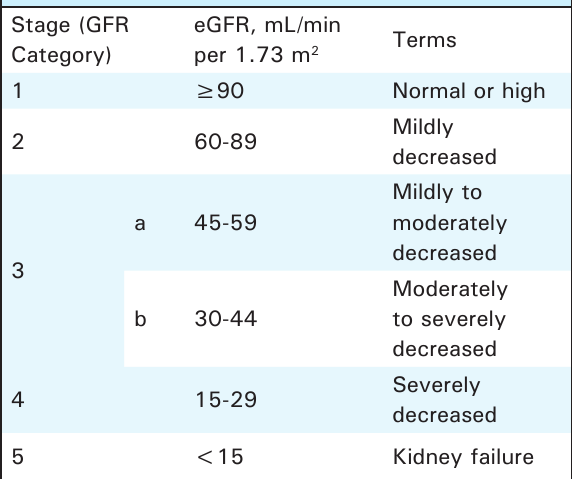
Table 1. CKD staging based on estimated GFR.